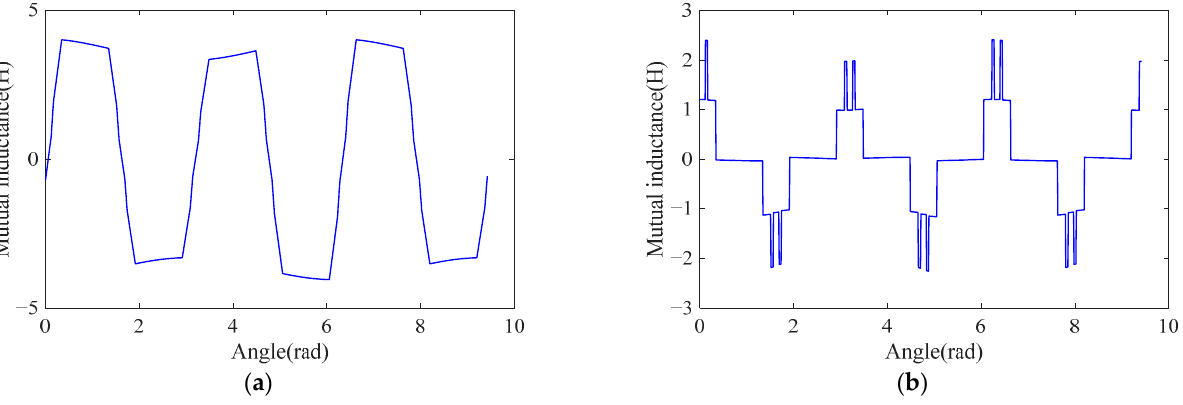
Figure 7. Stator–rotor mutual inductance and its differential curve under the condition of uniform air gap. ( a ) Mutual inductance of stator phase a and rotor bar 1 with rotor angular position; ( b ) mutual inductance difference between stator phase a and rotor bar 1.